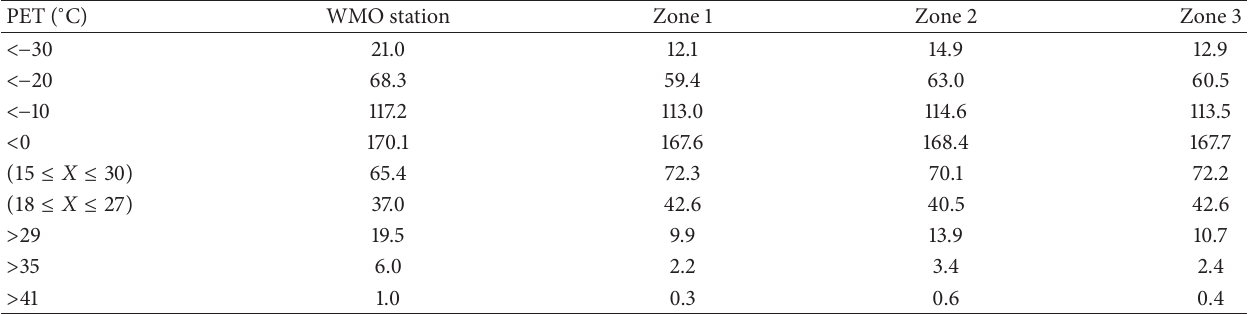
Table 2: Mean number of days per year with PET values within a specific class for the 3 zones as well as the climate station in Birobidzhan